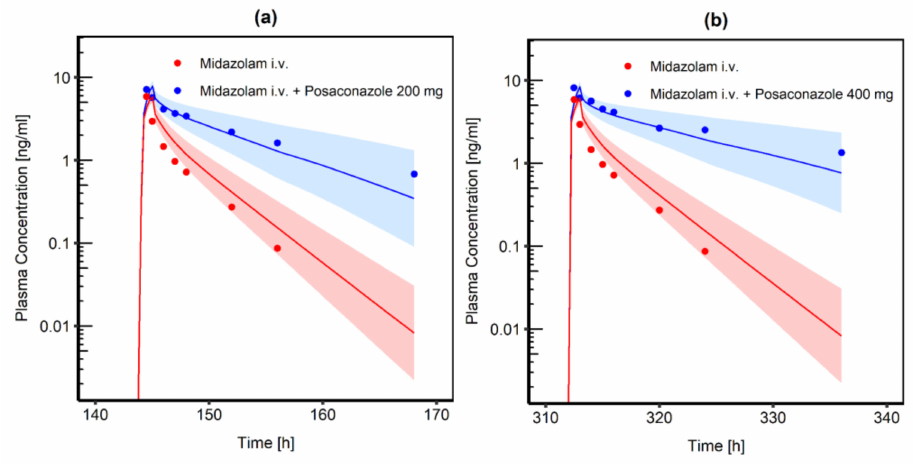
Figure 3. Comparison of simulated MDZ venous blood plasma concentration-time profiles (semilog- arithmic) following i.v. administration of 0.4 mg MDZ infusion. The blue shaded area represents the geometric mean SD for population simulations of the resulting MDZ plasma concentrations if co-administered with either ( a ) 200 mg oral POS or ( b ) 400 mg oral POS and an inhibitory constant Ki = 5.22 nmol/L for the CYP3A4 interaction process. The red shaded area represents the geometric mean SD for population simulations without concomitant POS administration. Geometric means are shown as a blue line (with POS administration) or a red line (without POS administration). Observed data are shown as blue and red dots, respectively. Table 1. DDI ratio for C max and AUC last calculated for the administration of MDZ together with POS.